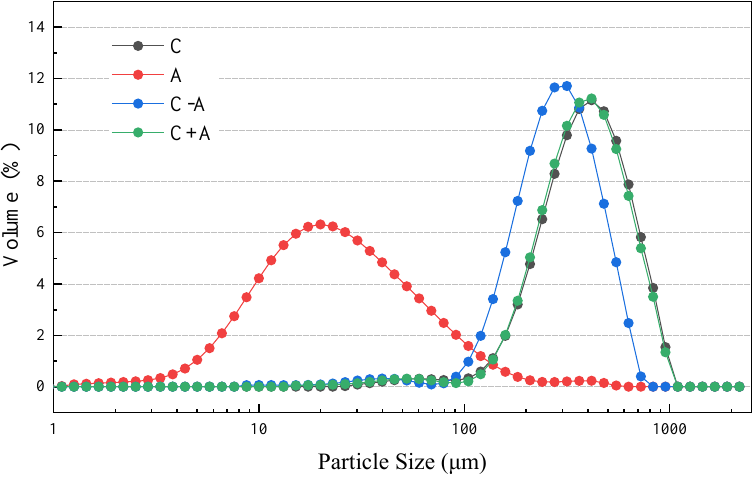
Figure 3. The particle size distribution in the effluents after different pre-treatment jar tests.